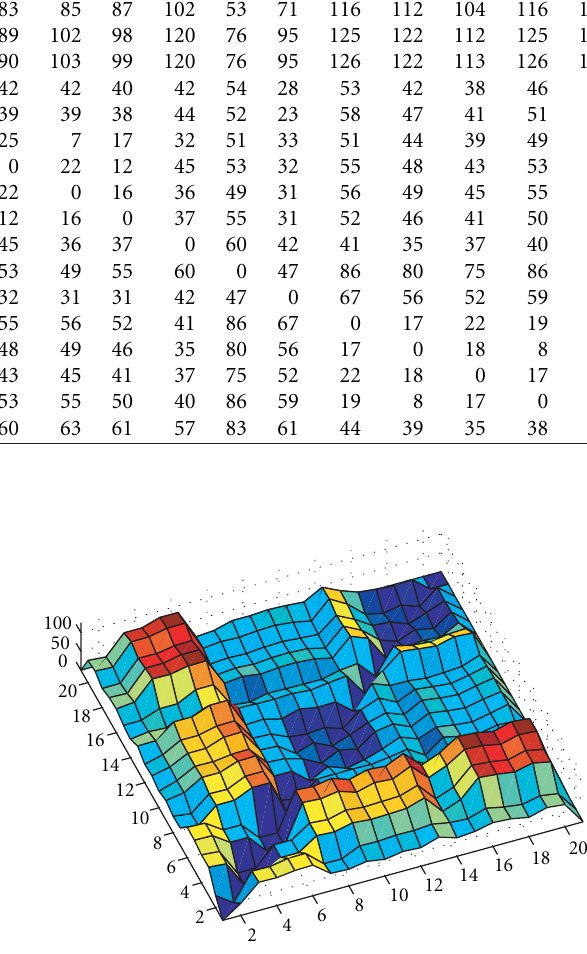
Figure 7: Contours of test set 2 after alignment. tours represent the same bird contour rotated or rotated and scaled. Therefore, we can safely say that our measures have a 0 . 5% error, which can be explained by the small contour variation introduced by rotation and the size reduction of the distance maps. Lower error can be obtained by increasing the size of the distance map images and reducing the block size used for the metaslices creation.